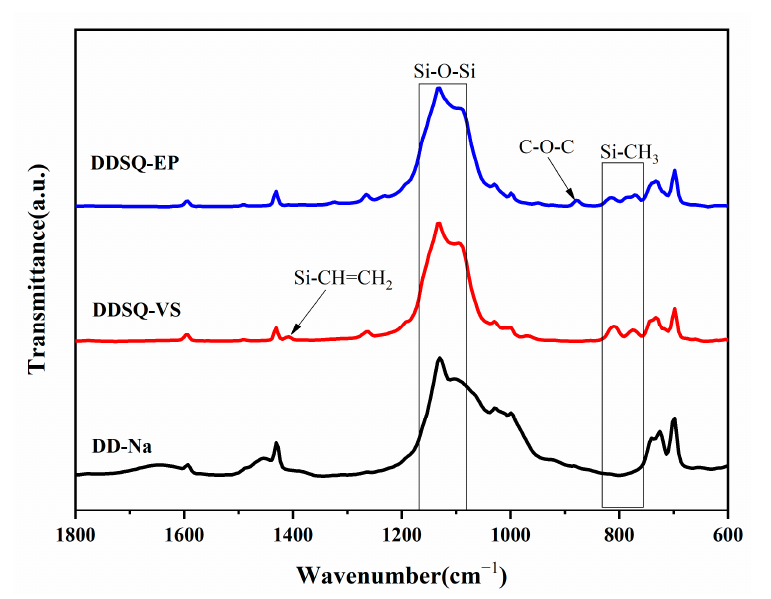
Figure 3. FTIR spectra of DD-Na, DDSQ-VS and DDSQ-EP.